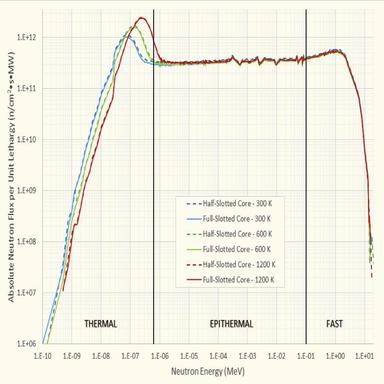
Comparison of Peak Neutron Flux Spectral Distribution with Increasing Core Temperature.